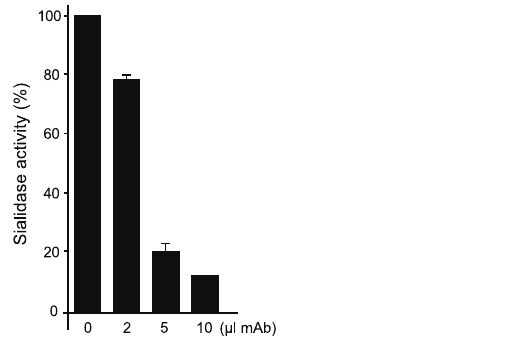
Figure 6. mAb 13G9 inhibits TS-catalyzed MU-NANA hydroly- sis. TS (50 ng) was incubated with increasing amounts of 13G9 hybridoma supernatant for 10 min as indicated, then 200 m M MU-NANA was added and incubation continued for 30 min. Controls with complete medium were run in parallel.